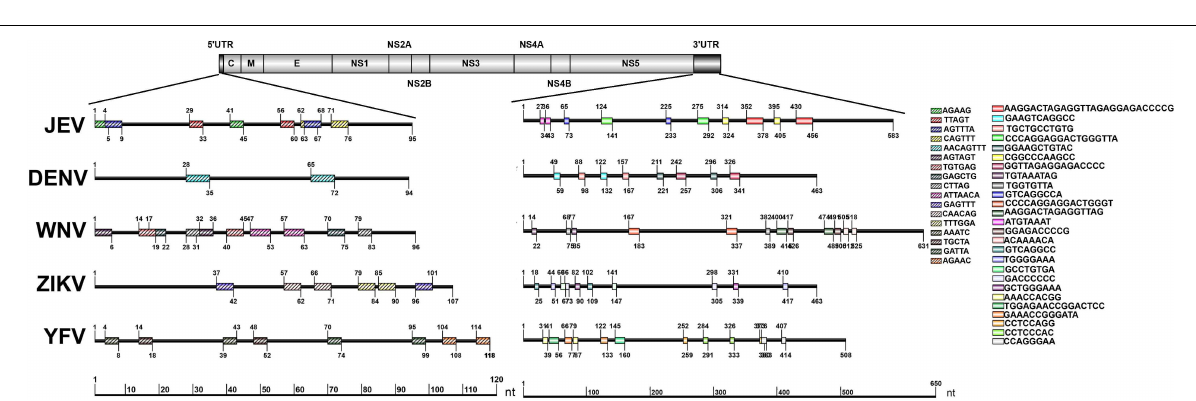
FIGURE 3 | Schematic localization of the repeat sequences in UTRs of different genotypes of JEV. Different color boxes indicate different repeat sequence units. The start and end positions of the repeat sequence unit is labeled upward and downward lines, respectively.